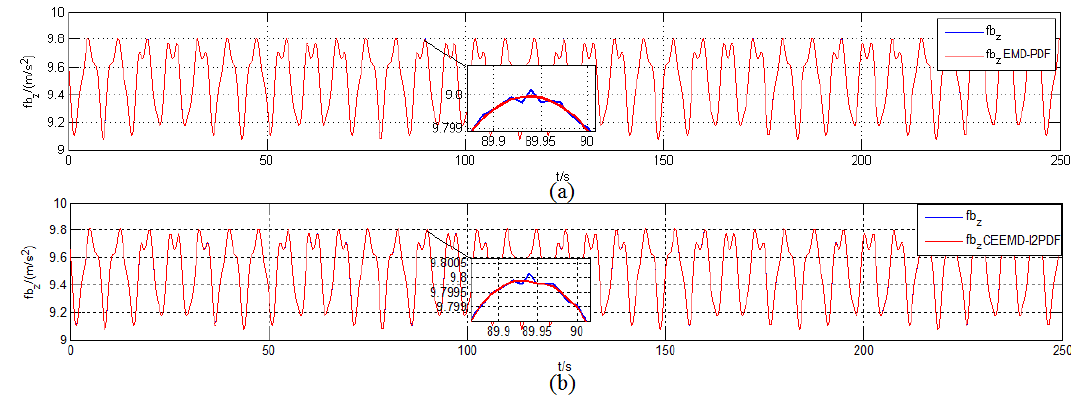
Figure 7. Denoising results of ˜ f b in the simulation. ( a ) EMD-PDF method; ( b ) CEEMD- l 2 PDF z